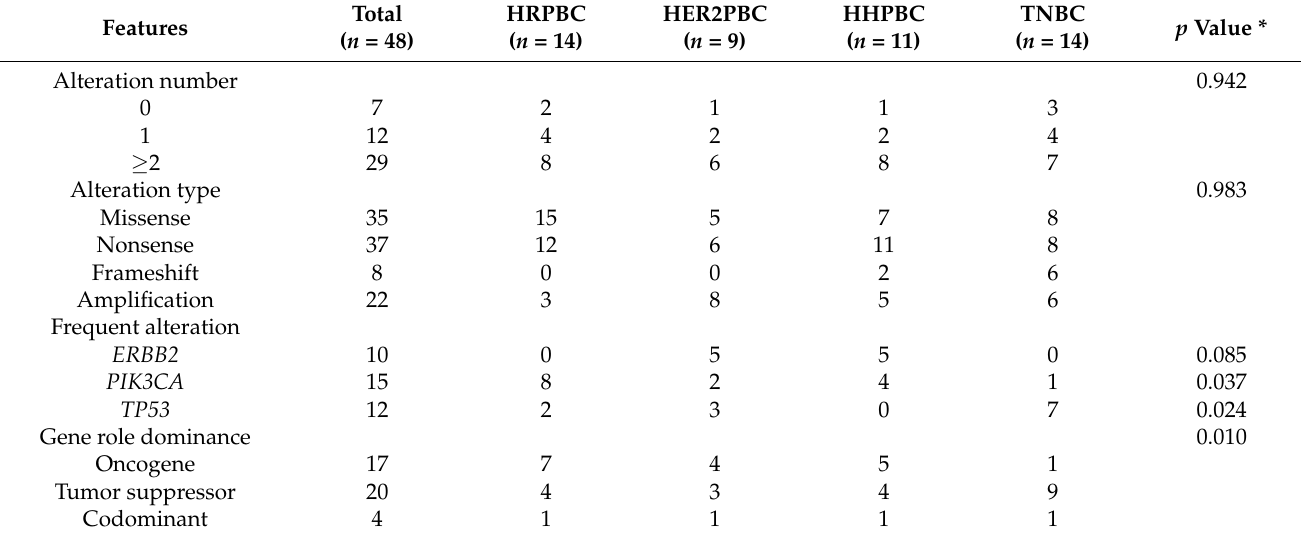
Table 2. Comparison results of somatic alteration profiles in 48 Korean patients with breast